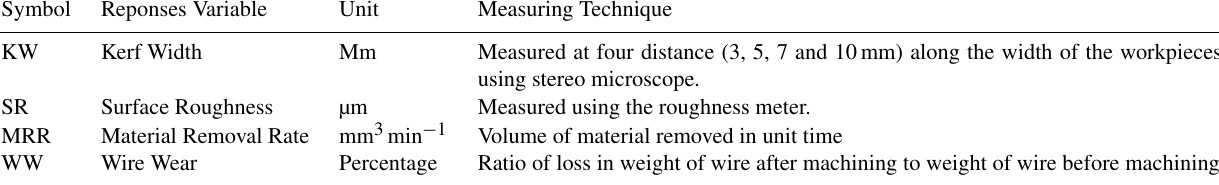
Table 3. Response variable used in the research. Symbol Reponses Variable Unit Measuring Technique KW Kerf Width Mm Measured at four distance (3, 5, 7 and 10mm) along the width of the workpieces using stereo microscope. SR Surface Roughness µm Measured using the roughness meter. MRR Material Removal Rate mm 3 min − 1 Volume of material removed in unit time WW Wire Wear